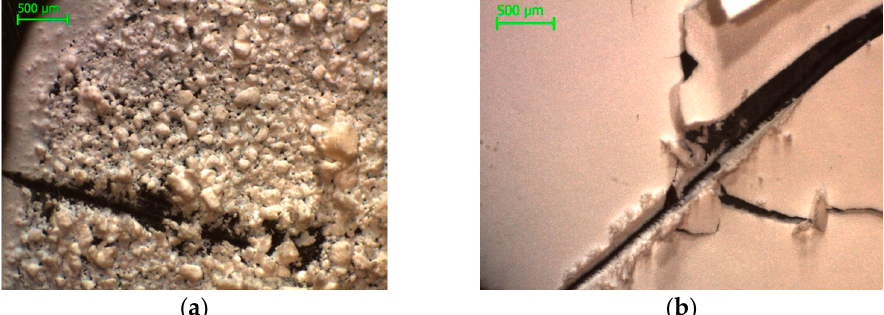
Figure 1. ECS-13P film without ( a ) and with ( b ) ethanol addition and magnetic stirring treatments. Images obtained by a stero-optical microscope Leica EZ4.